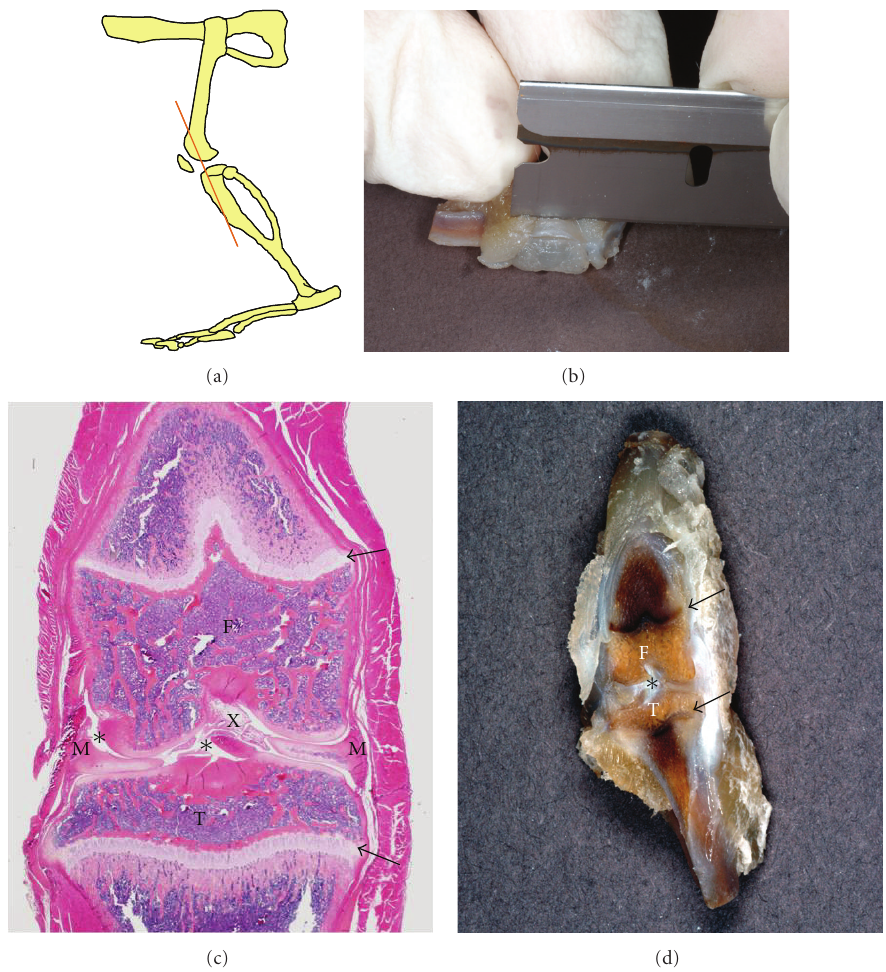
Figure 7: Tissue trimming procedure for reliable and reproducible production of high-quality sections through the rodent femorotibial (knee) joint. A skeletal schematic diagram (a) shows the location of the cut required to isolate the knee region at the appropriate plane, as viewed from the lateral side. The tissue along the cranial (front) surface of the knee is removed ((b), oriented with the distal tibia to the left) a few millimeters at a time while holding the razor blade parallel with the cranial surface of the tibia. The appearance of the properly trimmed joint (d) will show the distal femur (F) and proximal tibia (T) separated by the joint space (asterisk ( ∗ )), as well as the physis (growth plate) for both bones (arrows). The appearance of the corresponding histologic section from a nonarthritic rat (c) reveals additional features within the joint space including the menisci (M) associated with the femoral condyles and the cruciate ligaments (X). Histologic stain: hematoxylin and eosin